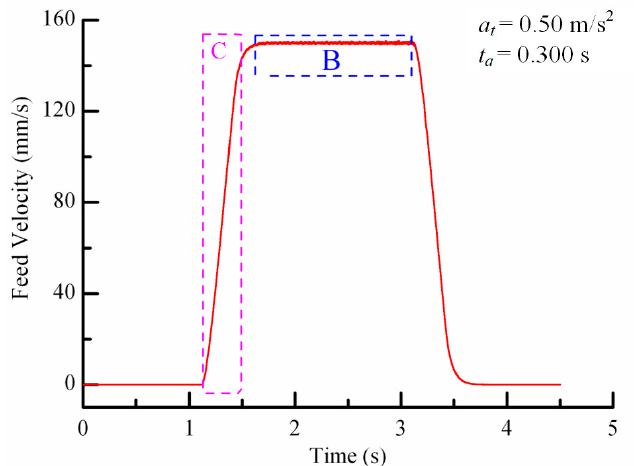
Figure 8. The speed of the worktable in the feed direction. B is the uniform velocity interval, C is the acceleration interval.